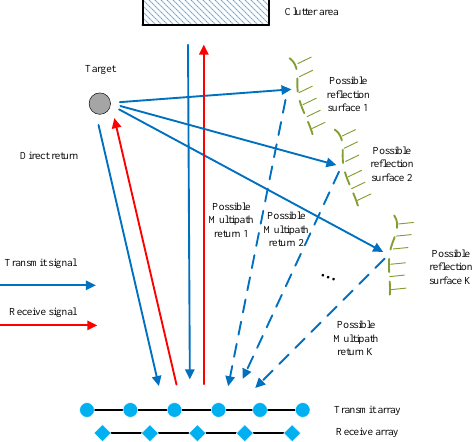
Figure 1. The considered scenario in the presence of multipath